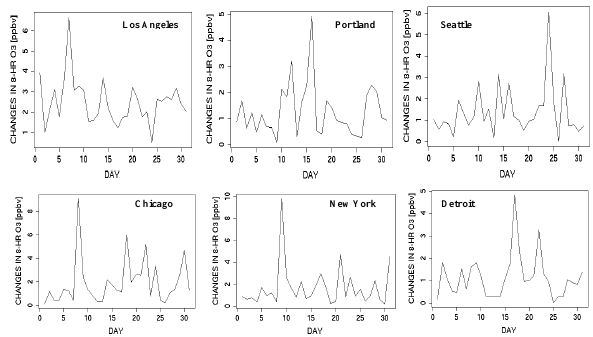
Figure 5: (a) Monthly mean daily 8-hr maximum O 3 with CB05-Base (b) absolute increases in mean daily 8-hr maximum O 3 between CB05-TU and CB05-Base.